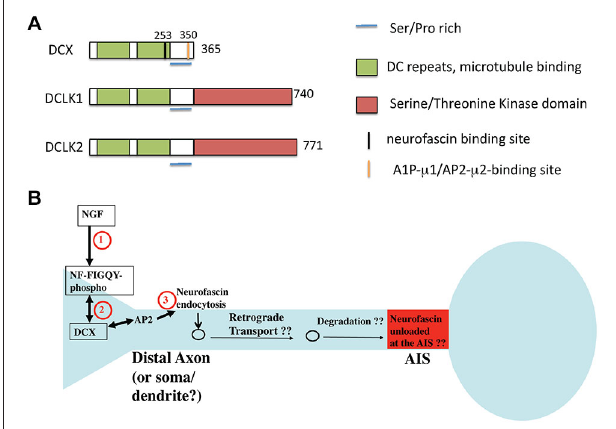
FIGURE 5 | Domain structure of DCX and related proteins DCLK1 and 2. (A) The domain structure of DCX and DCLK1/2 is depicted. Binding regions are indicated by color bars. (B) Model of DCX as an endocytic adaptor (based on Yap et al., 2012). DCX binds to the phosphorylated FIGQY motif of the adhesion receptor neurofascin. DCX can bind to AP-2 via its C-terminal YLPL motif and mediate endocytosis of phospho-neurofascin. Neurofascin endocytosis reduces its levels on soma and dendrites and contributes to its gradual accumulation on the axon initial segment (AIS). If endocytosed neurofascin is subsequently degraded or recycled to the AIS is not